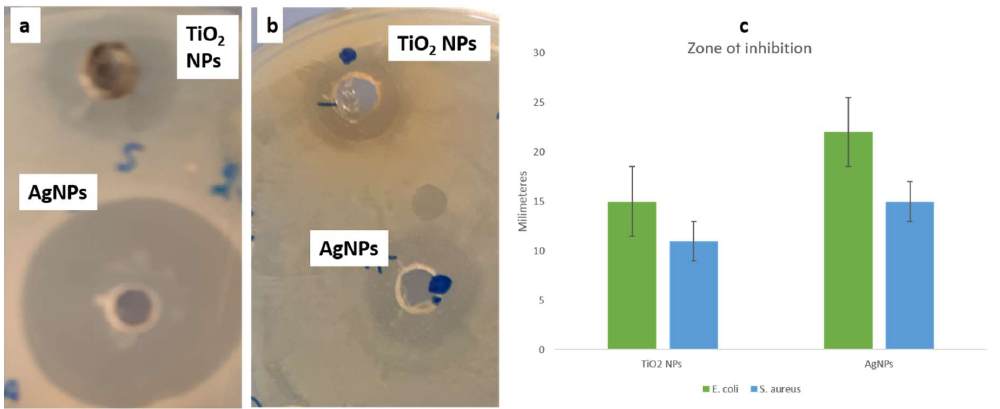
Figure 6. Zone of inhibition by agar well diffusion at 100 µg/mL of NPs; ( a ) E. coli and ( b ) S. aureus ( c ) Graph depicting ZOI. ( c ) Graph depicting